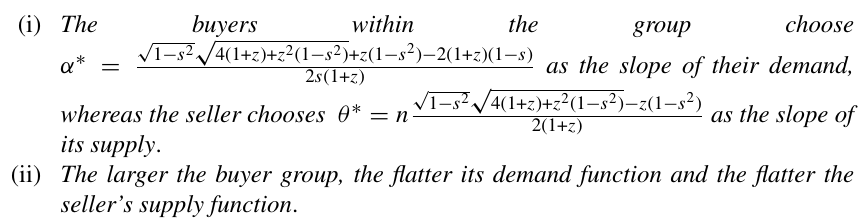
( θ ) > 0 and Ψ (cid:6) ( α ) > 0, that is, BG S